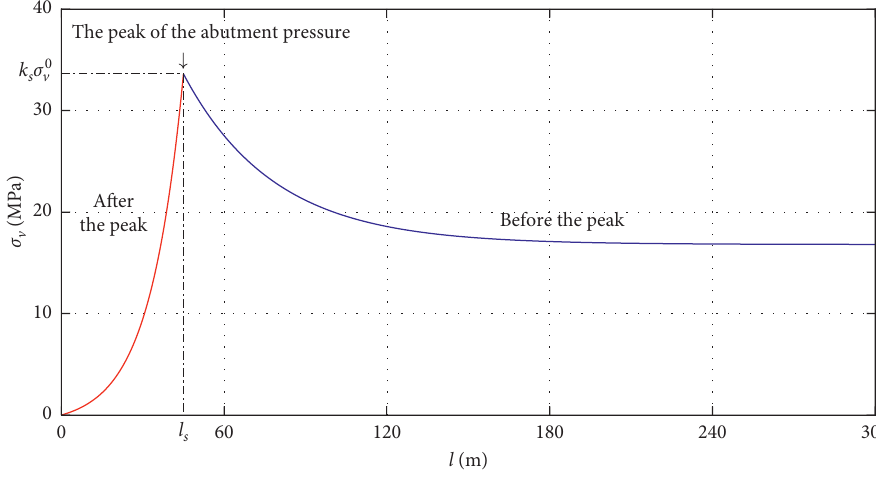
Figure 3: The abutment pressure curve.